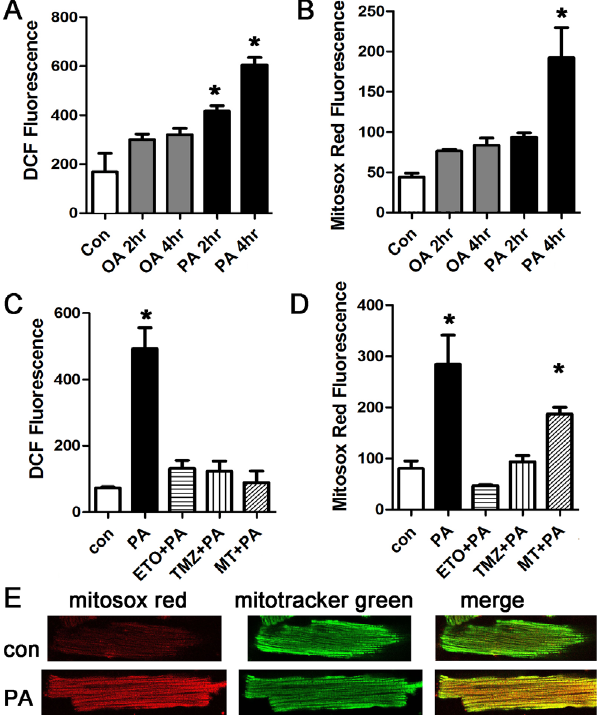
Fig 2. Cardiomyocytes treated with palmitate have increased total and mitochondrial ROS. A. Representative experiment done with cardiomyocytes in triplicate, height is DCF fluorescence minus background, in live cells, expressed in arbitrary units, mean + SEM. Palmitate, but not oleate, increases ROS significantly. PA = palmitate 200 μ M, OA = oleate 200 μ M, B. Cardiomyocytes from the same experiment using mitosox red readout to indicate mitochondrial ROS. C. Inhibition of mitochondrial lipid uptake or beta- oxidation prevents the increase in ROS. ETO = etomoxir 200 μ M, TMZ = trimetazidine 10 μ M, MT = mito- TEMPO, 20 μ M. D. Cardiomyocytes from the same experiment using mitosox red readout. For all panels, means are significantly different by ANOVA, * = sig different from control by post-hoc test. E. Confocal images of live isolated cardiomyocytes after control and palmitate treatment. Cells were stained with mitosox red and counter-stained with mitotracker green.